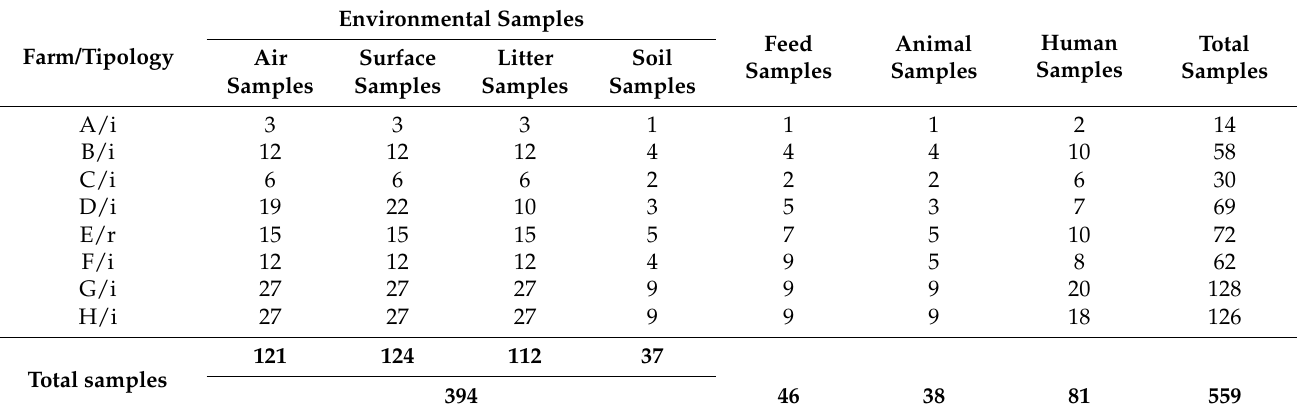
Table 1. Sample distribution by farm. Legend: i = intensive; r =